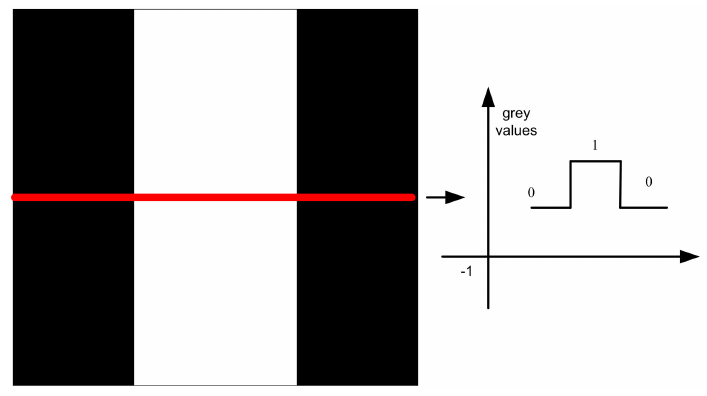
Figure 5. The binary reference template for the extraction of road